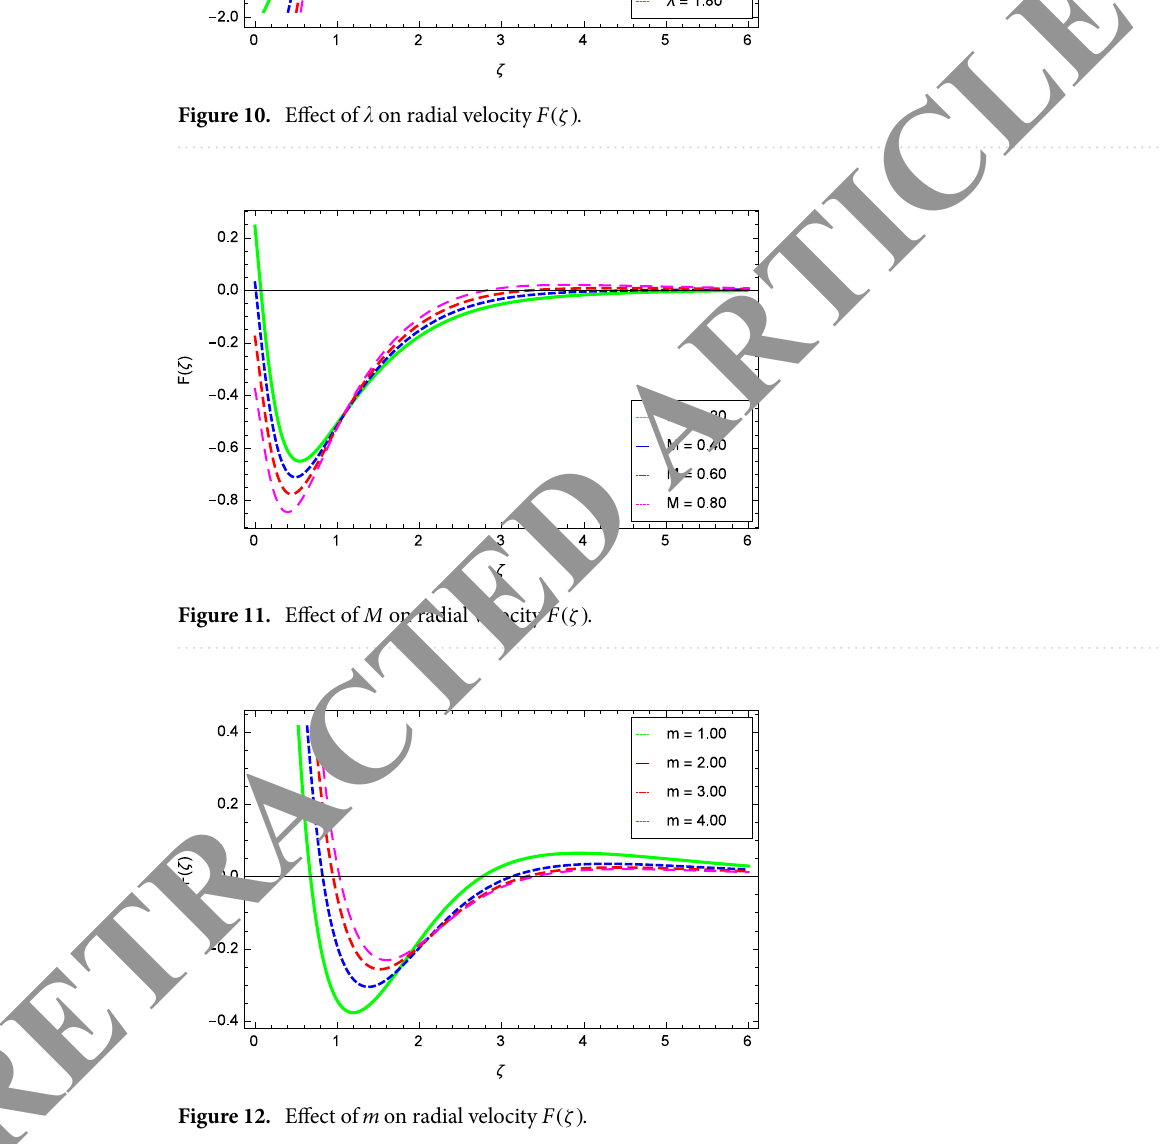
Figure 12. Effect of m on radial velocity F (ζ) .